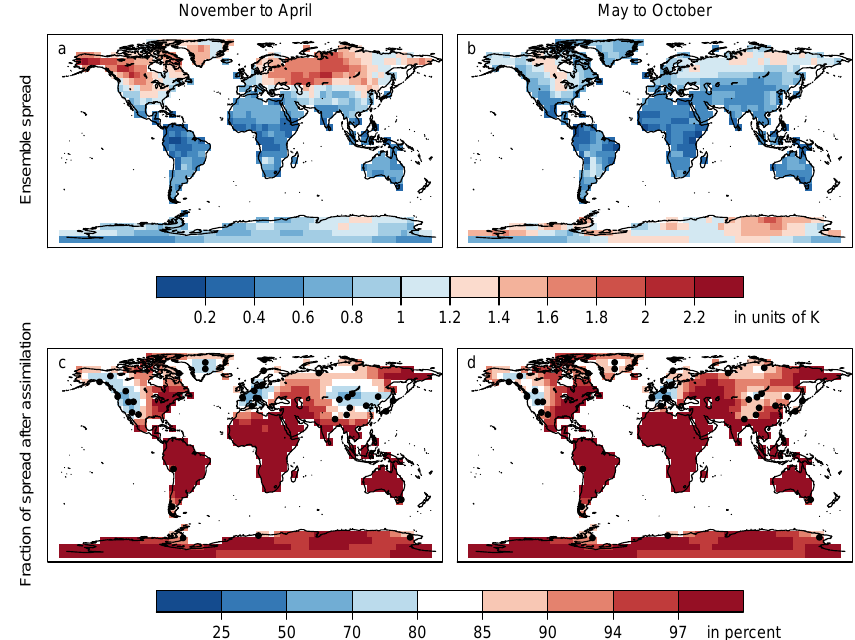
Fig. 5. Average intra-ensemble standard deviation (spread) for temperature of the ECHAM ensemble in winter ( a , November to April) and summer ( b , May to October). Percentage of the intra-ensemble standard deviation in the analysis ensemble with respect to the unconstrained ensemble for the EnSRF analysis with pseudo-proxies and localisation in c and d.